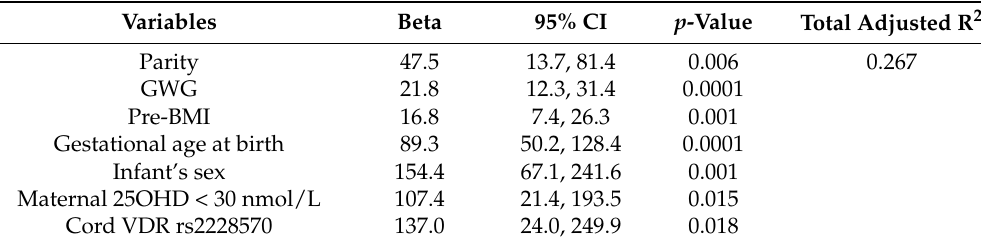
Table 5. The final model of factors associated with infant birth